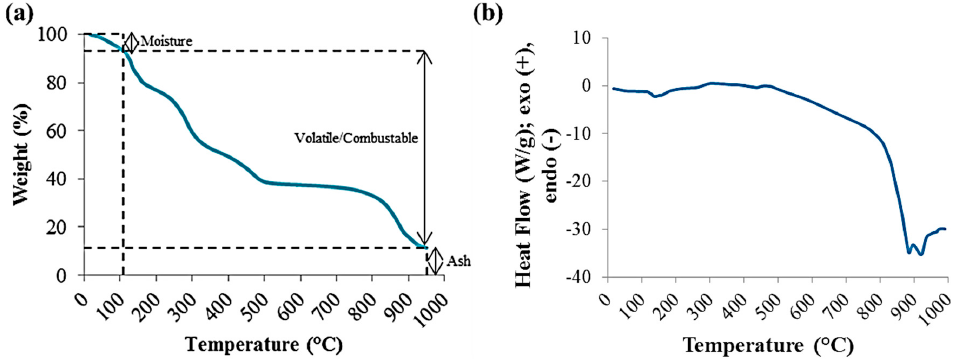
Figure 1. Thermal Analyses of Raw Dried Red Liquor using TGA ( a ) and DSC ( b ).